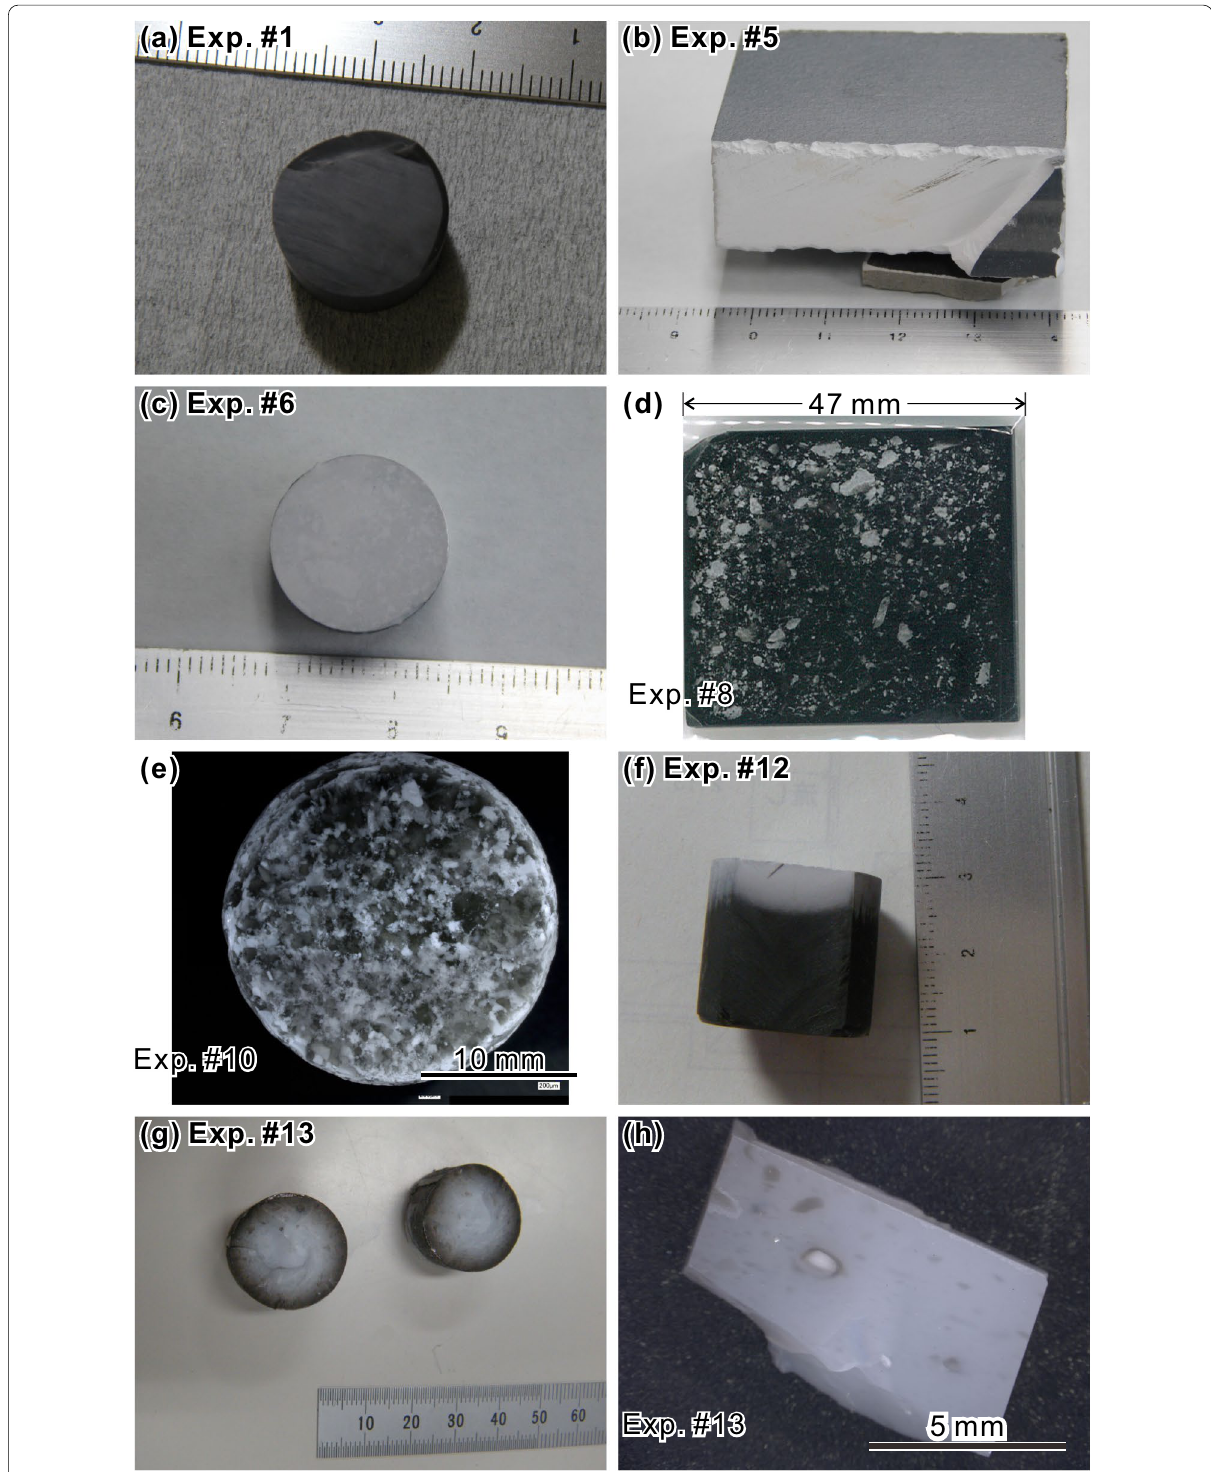
Fig. 4 Visual appearance of hot‑pressed samples. a , b Samples from the powders after 6 h of decantation and hot‑pressed at 50 MPa and a 1150 °C (Exp. #1) and b 1050 °C (Exp. #5). c , d Samples from the powders after 24 h of decantation and hot‑pressed without CAS conditions at 50 MPa and 1100 °C for c 17 h (Exp. #6) and d 100 h (Exp. #8). e , f Sample from the powders after 24 h of decantation and hot‑pressed e without (Exp. #10) and f with (Exp. #12) CAS conditions at 1080 °C and 100 MPa. g , h Sample prepared from a green body by slip casting and hot‑pressed at 1080 °C and 120 MPa (Exp.